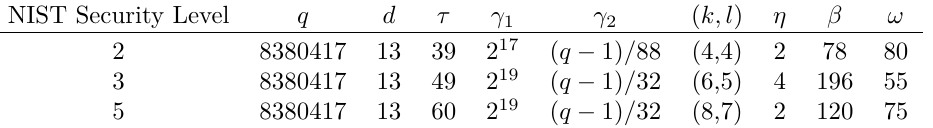
Table 1: Parameters of the three Dilithium security levels in round